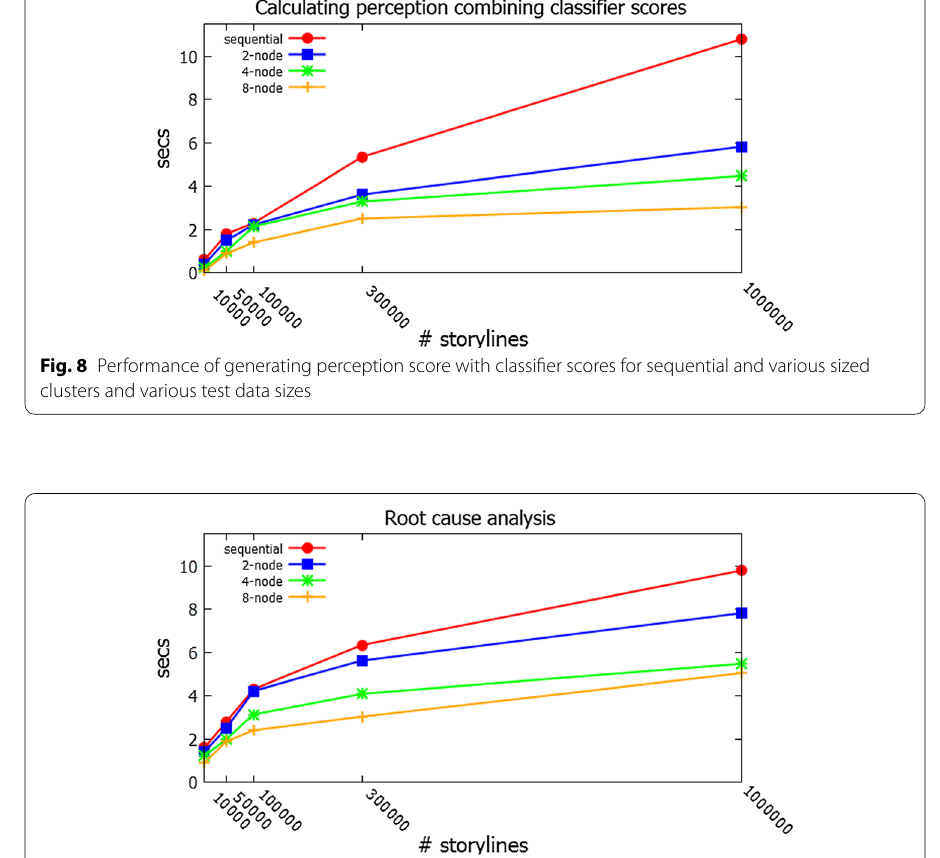
Fig. 9 Mapping storyline entities back to tweets for root cause